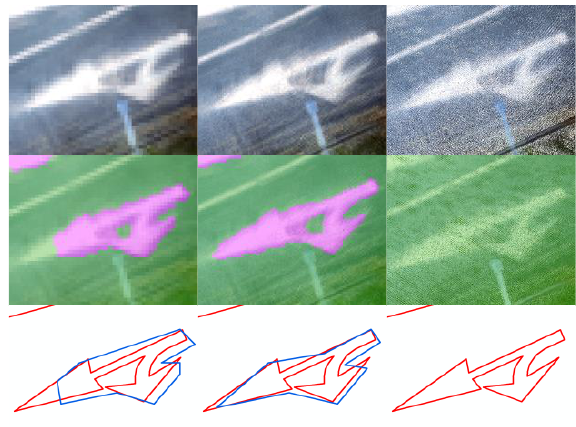
Figure 17. Sample arrow #1 – head straight or turn right